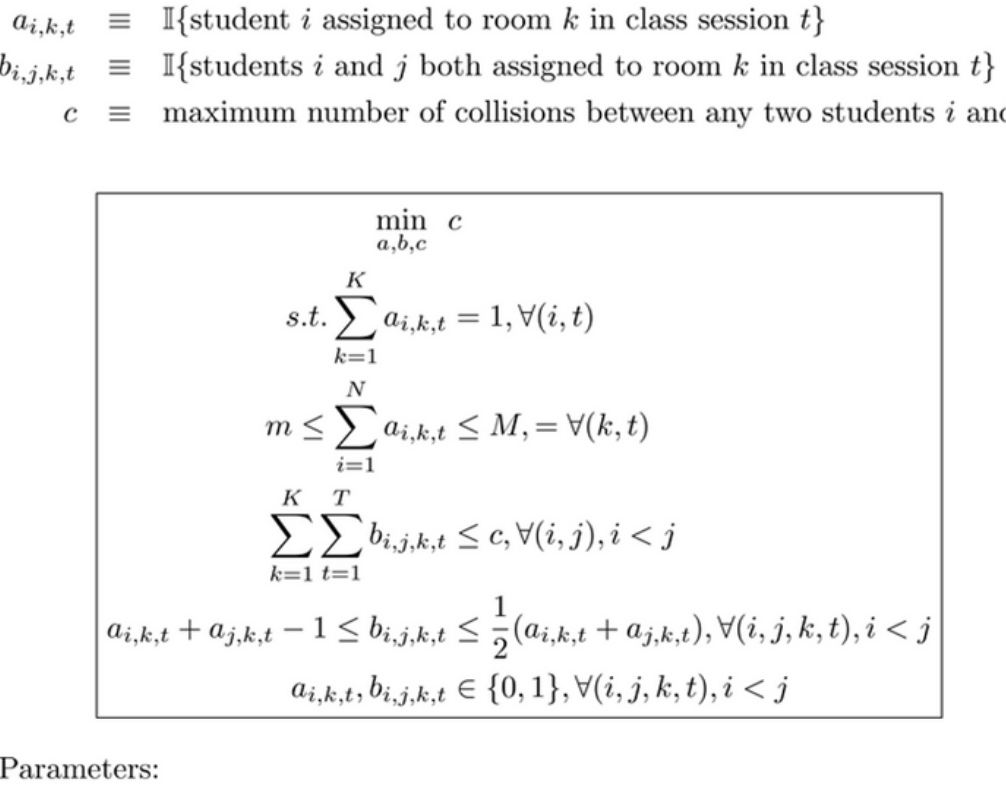
Figure 2. Optimization problem to generate breakout-room assignments so as to maximize the number of networking opportunities among students during the semester. See Xu (2020) and corresponding Julia code for details, both of which are available at